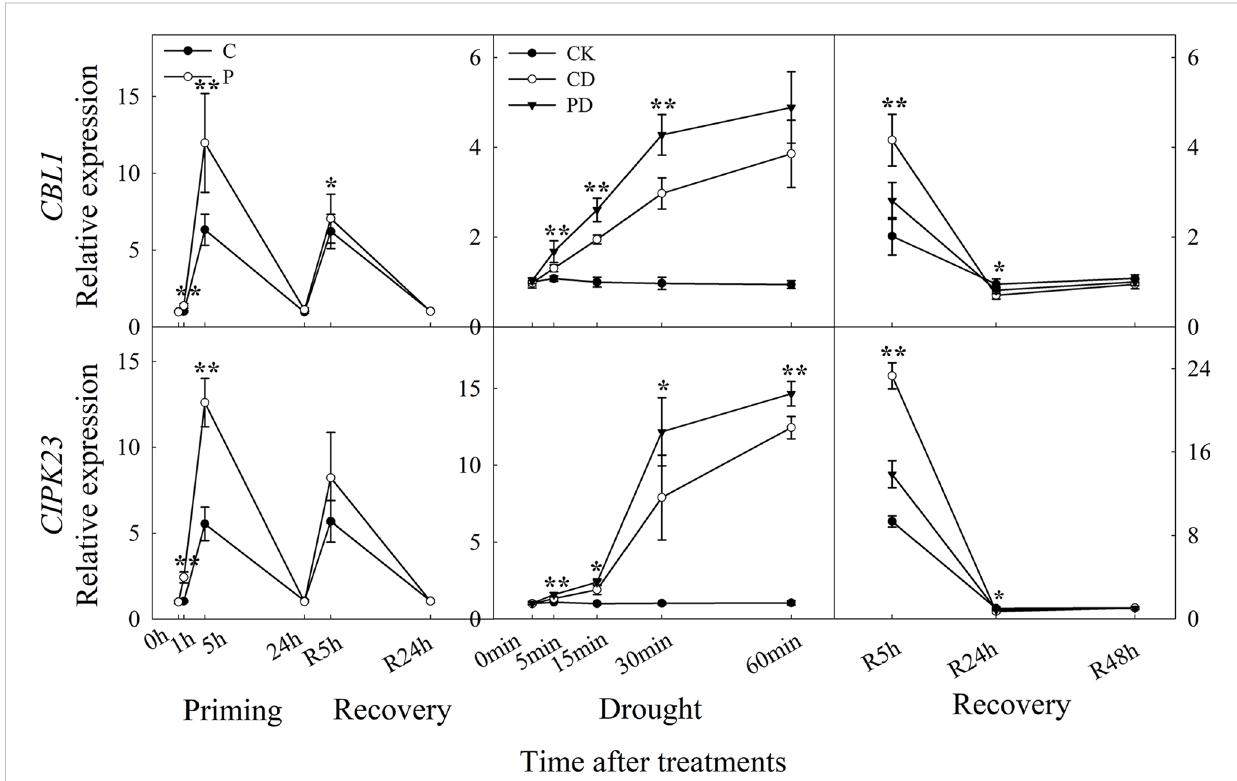
FIGURE 5 Dynamic responses of calcium ion signaling pathway related genes in leaf epidermis of wheat during “ drought priming-recovery-drought stress- recovery ” . C, no drought priming; P, priming; CK, no drought priming + no drought stress; PD, priming + drought stress; CD, no priming + drought stress. *p < 0.05; **p <